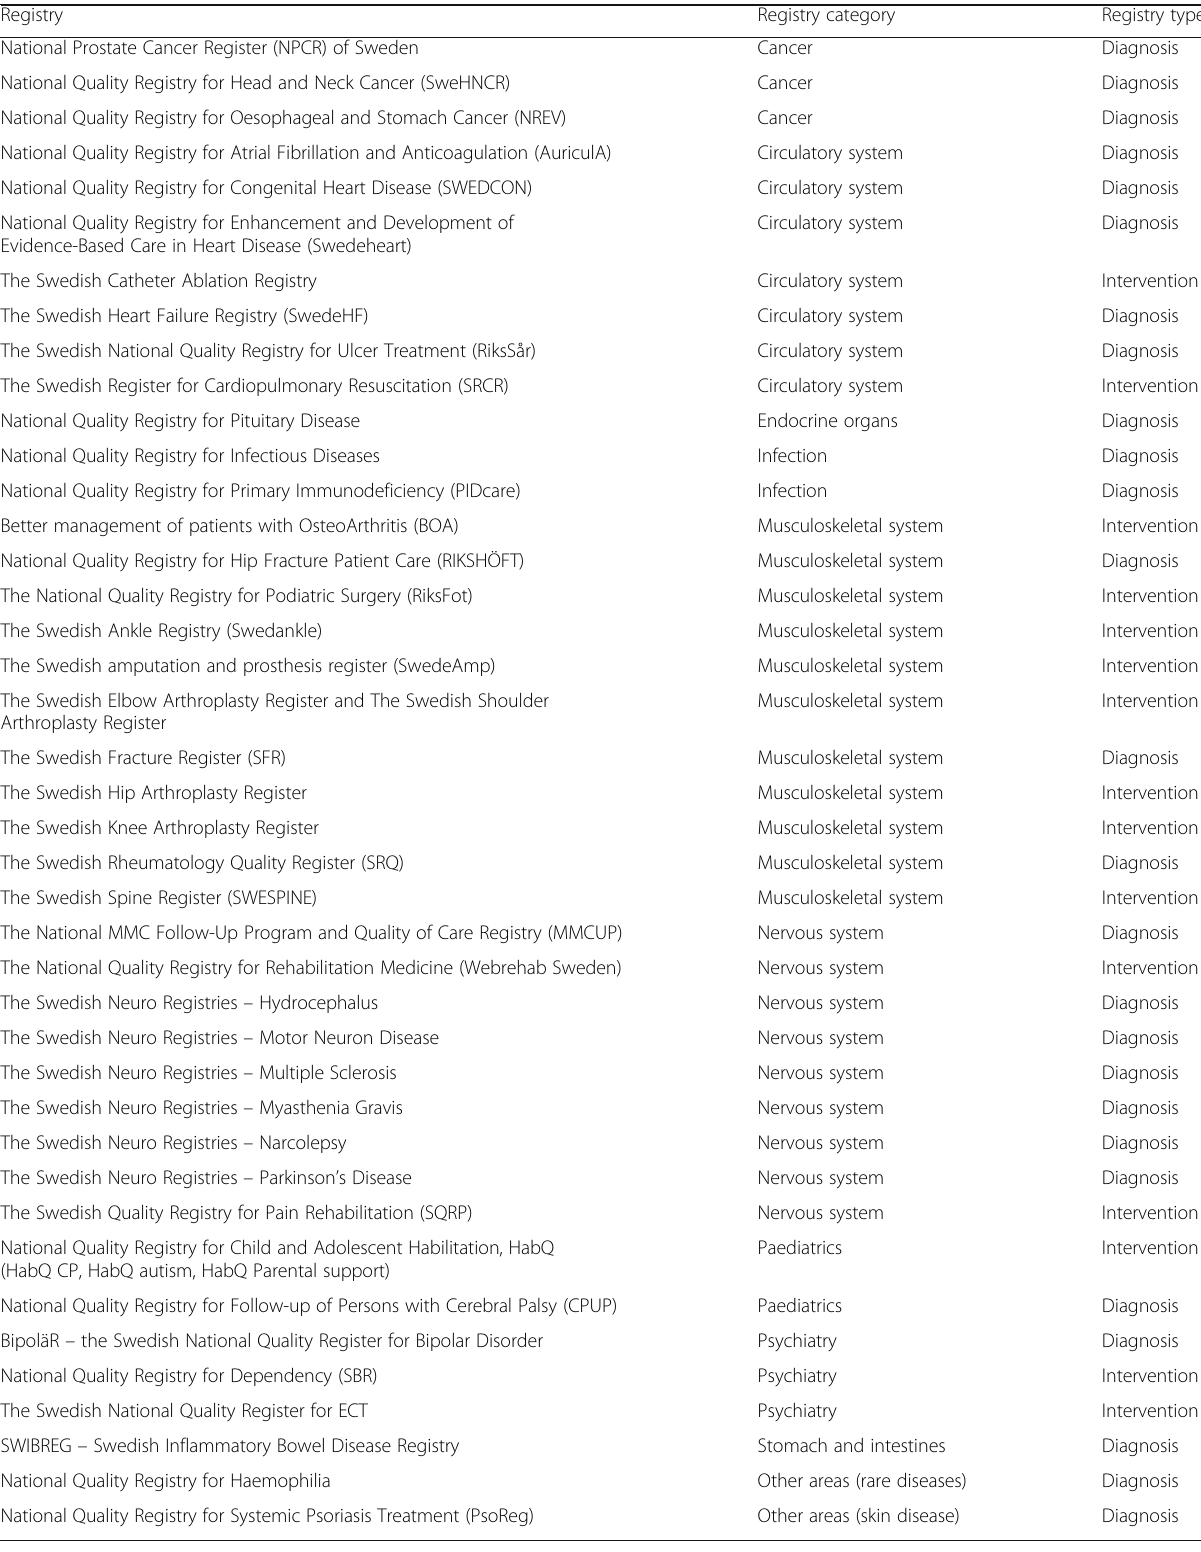
Table 1 Swedish National Quality Registries collecting EQ-5D data,